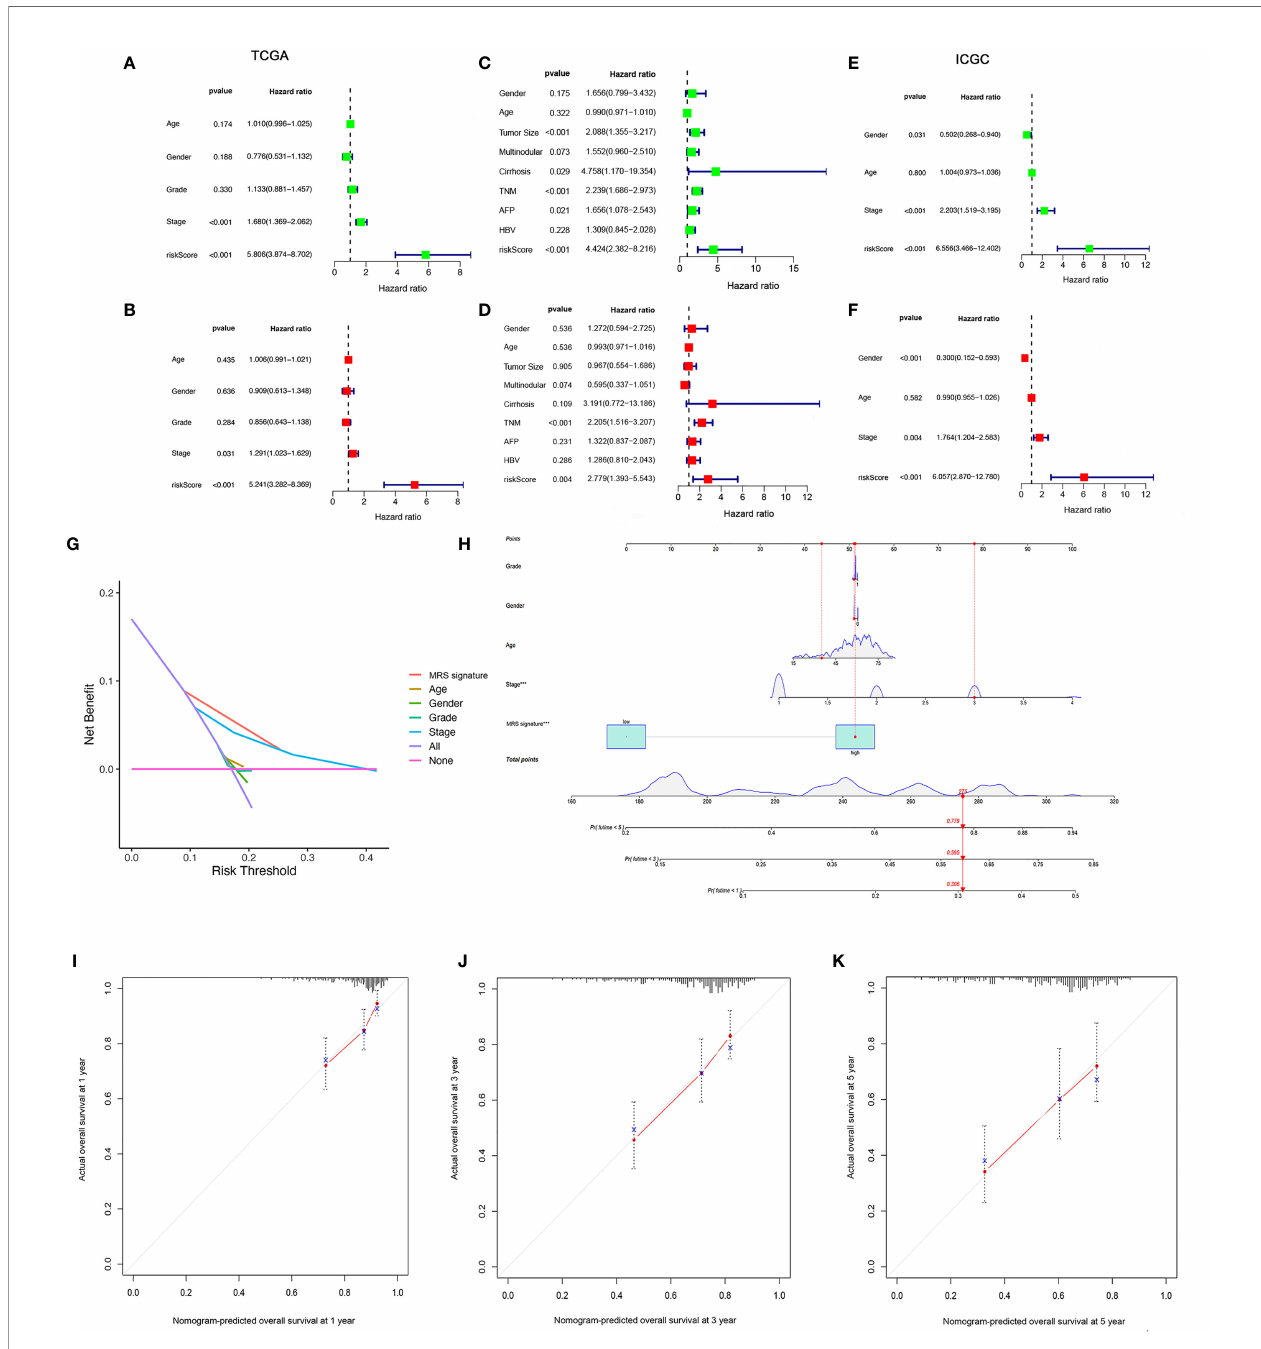
FIGURE 7 | Establishment and assessment of the nomogram for survival prediction. (A, B) Univariate and multivariate Cox regression analyses showed that risk score based on macrophage-related clusters is an independent prognostic factor affecting the prognosis of HCC patients in the TCGA-LIHC dataset. (C, D) Univariate and multivariate Cox regression analyses showed that risk score based on macrophage-related clusters is an independent prognostic factor affecting the prognosis of HCC patients in the GSE14520 dataset. (E, F) Univariate and multivariate Cox regression analyses showed that risk score based on macrophage-related clusters is an independent prognostic factor affecting the prognosis of HCC patients in the ICGC dataset. The decision curve analysis of the 1-year overall survival in the TCGA-LIHC dataset (G) . (H) The nomogram combining risk score based on macrophage-related clusters and other clinicopathological parameters was developed to predict 1-, 3-, and 5-year survival. Calibration curves showing the predictions of the nomogram that we established for 1- (I) , 2- (J) , and 3-year (K) overall survival. *** P <